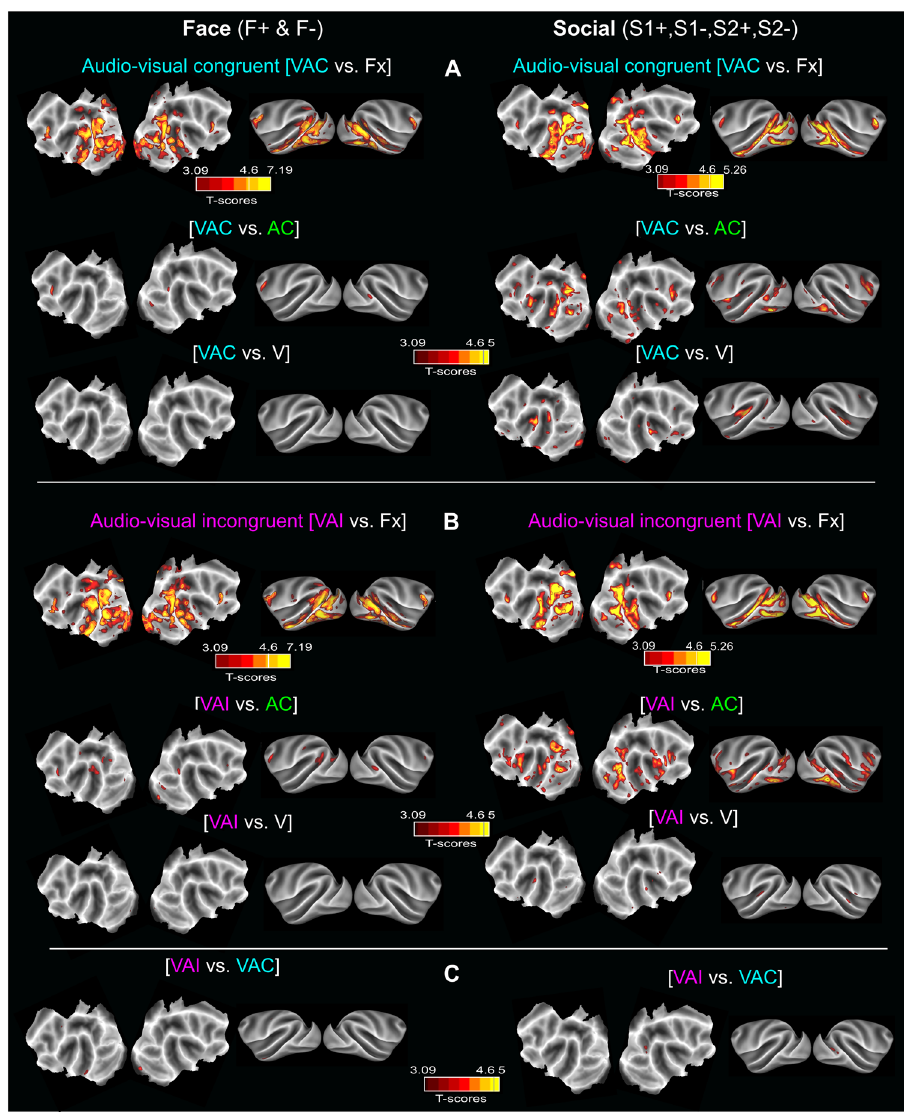
Fig. 9 | Whole-brain activations for the Face (F+& F − ) and Social contexts (S1+, S1 − , S2+& S2 − ): bimodal versus unimodal contrasts. A Whole-brain activation maps of the F+ (face af fi liative) and F − (face aggressive) runs (left panel) and the S1+,S2+(socialaf fi liative1&2),S1 − (socialaggressive)andS2 − (socialescape)runs (right panel) for the congruent audio-visual stimulation (blue). Contrasts from top to bottom: audio-visual vs. fi xation, audio-visual vs. auditory congruent and audio-